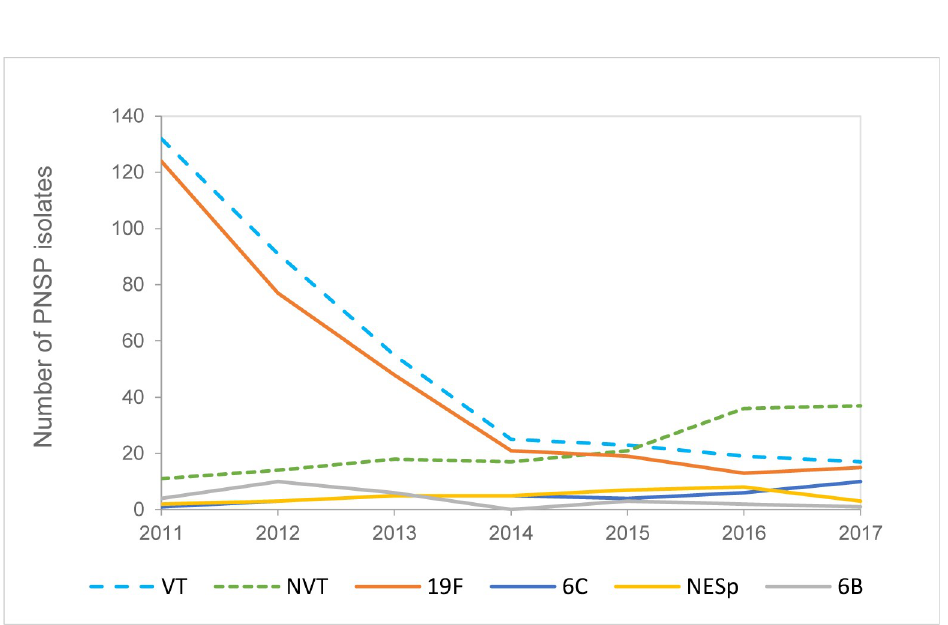
Fig 5. Annual numbers of PNSP isolates of vaccine and non-vaccine serotypes and their four most common serotypes. The total number of isolates of vaccine serotypes is presented by blue dotted line and of non-vaccine serotypes by green dotted line. The most common PNSP serotype was 19F, followed by 6C, non-encapsulated Streptococcus pneumoniae ( lyt A positive and csp A and csp B negative) ranked third and 6B fourth.